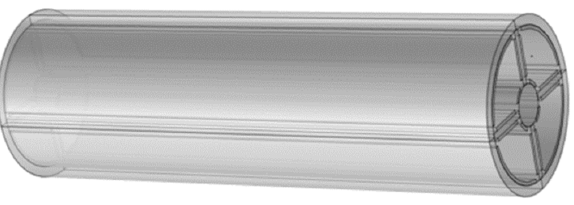
Figure 9. Simulation example diagram of three types of wear particles. ( a ) Abrasion; ( b ) Rolling fatigue; ( c ) Severe sliding wear.